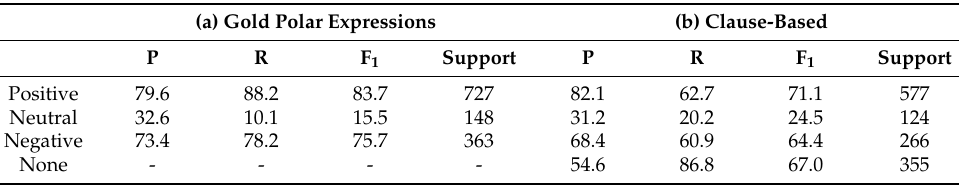
Table 7. Precision (P), recall (R), and F 1 -score percentages, and support by label for (a) gold polar expression and (b) clause-based implicit polarity classification.